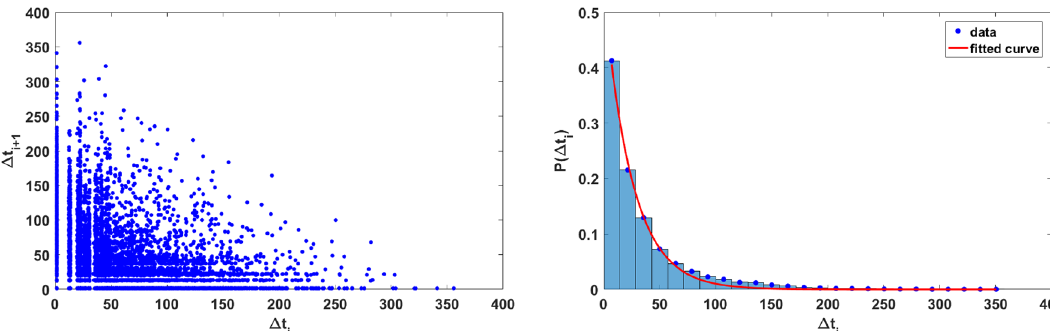
Figure 7. (Left) Return Map of (cid:31) t i + 1 versus (cid:31) t i , and (right) Probability distribution of (cid:31) t i fitted with exponentially decaying function, where (cid:31) t i is the i th interval between successive extreme events, where an extreme event is defined at the instant when the prey population crosses the µ + 7 σ line (cf. Fig. 2). Here θ = 0.024 .